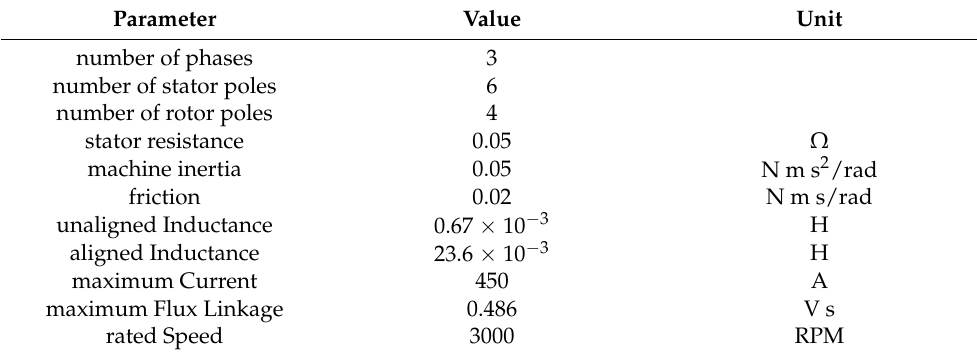
Figure 4. Magnetization curve for SRG model.